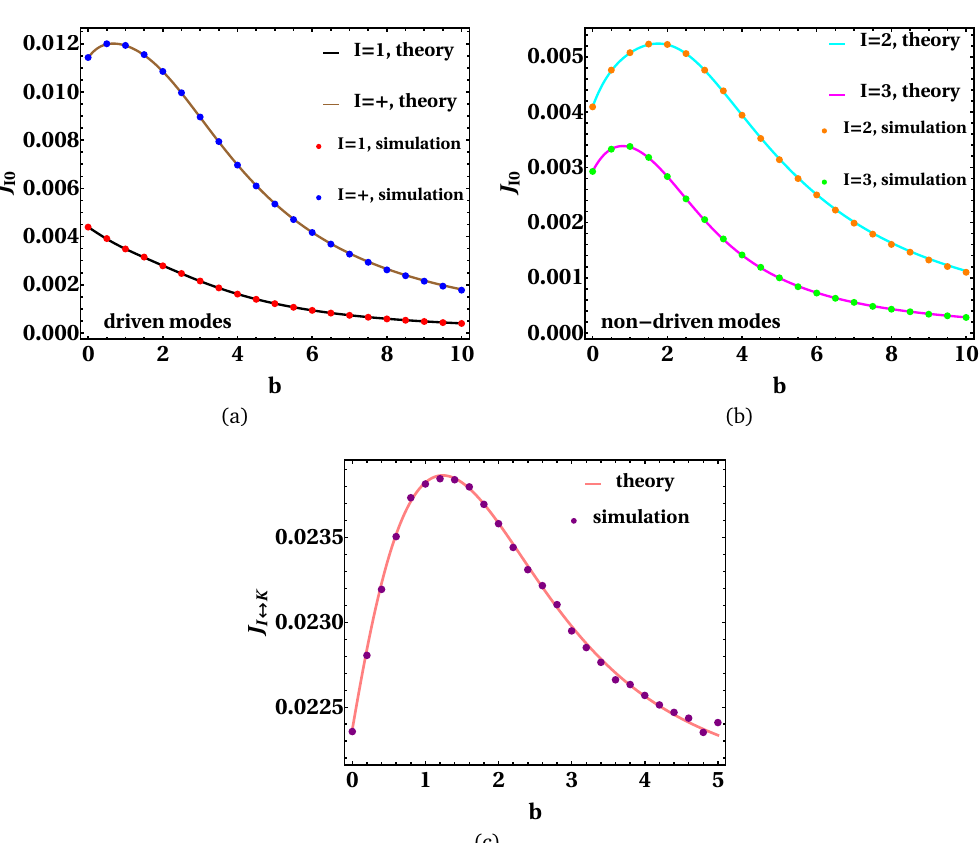
Figure 10: The figure illustrates the negative differential mobility of the currents in the 3-ASEP-IAF. In (a), the drift current of the species 1 (driven by bias b ) monoton- ically decreases with increasing bias. The current of the other driven mode (driven due to unidirectional motion with rate ε ) impurity ( + ) shows non-monotonic behav- ior, it increases initially but ultimately decreases with increasing bias for large values of b . In (b), the drift current of both non-driven modes (species 2 and species 3) decrease with increasing bias b for large values of the bias. The figure (c) shows that the flip current between any pair of species also exhibits negative differential mobility with increasing b . Although the flip current is not related to the drift bias b directly, still it decreases with increasing bias for large values of b . The parameters used here = q = 1.0, w = w = 0.8, w = w = 0.2, w = w are L = 10 3 , ε = 0.1, p 3 3 31 12 13 32 21